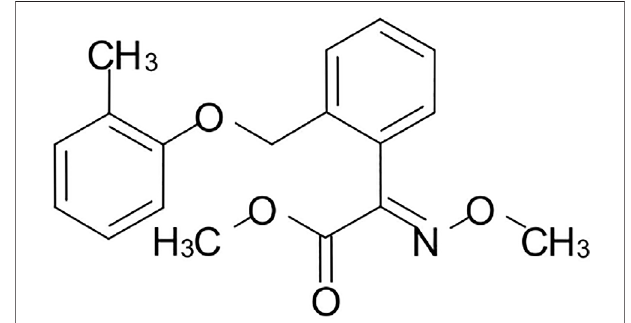
FIGURE 1 | Chemical structures of